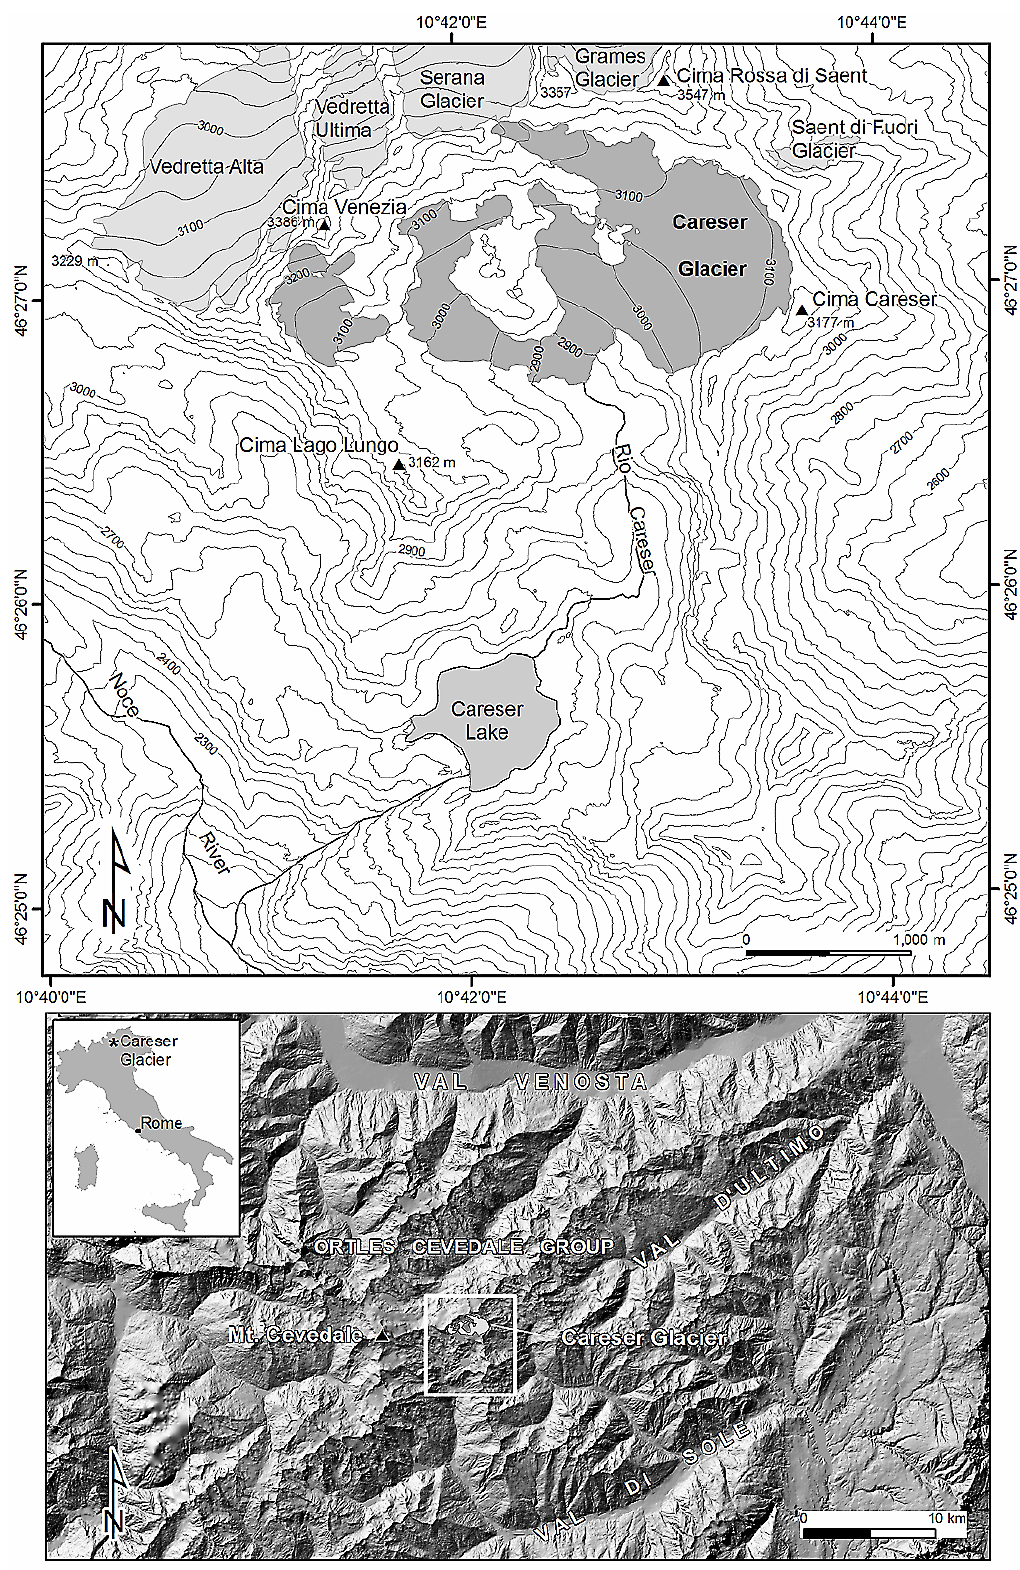
Fig. 1. Geographic setting of the Careser Glacier (2006 surface